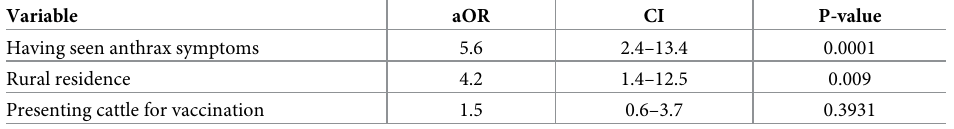
Table 5. Factors independently associated with having knowledge regarding anthrax, Kisumu East Sub County, July